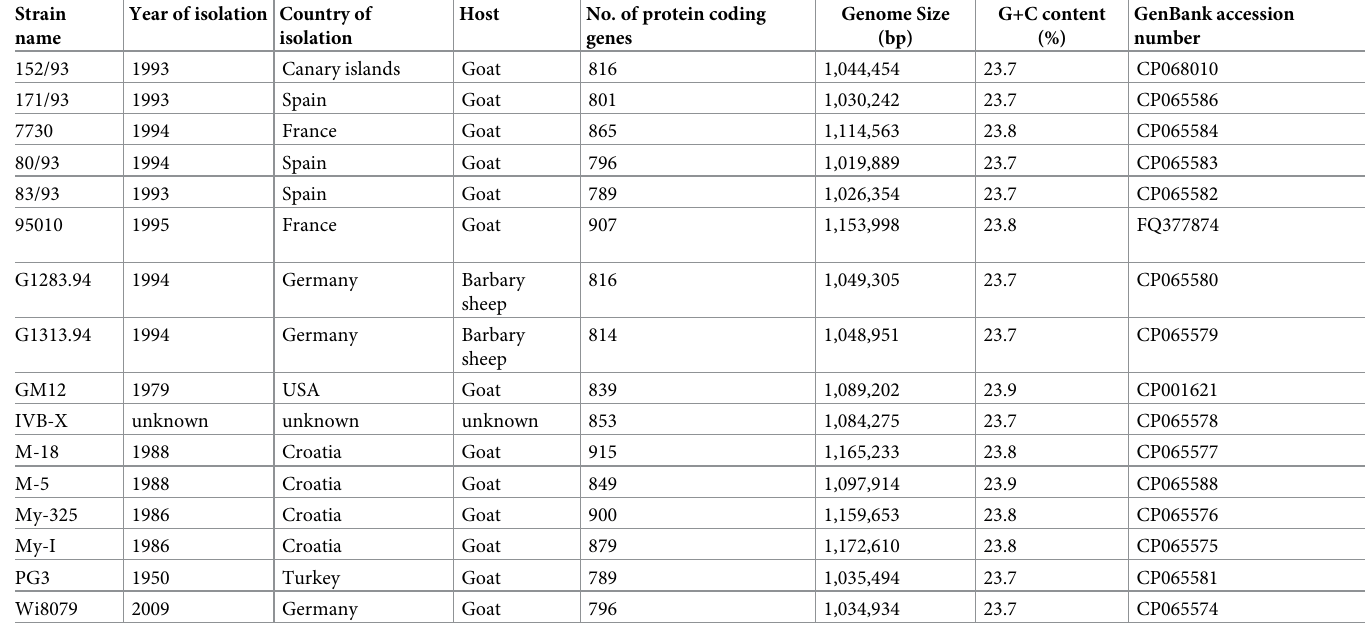
Table 2. M . mycoides subsp. capri strains used in this